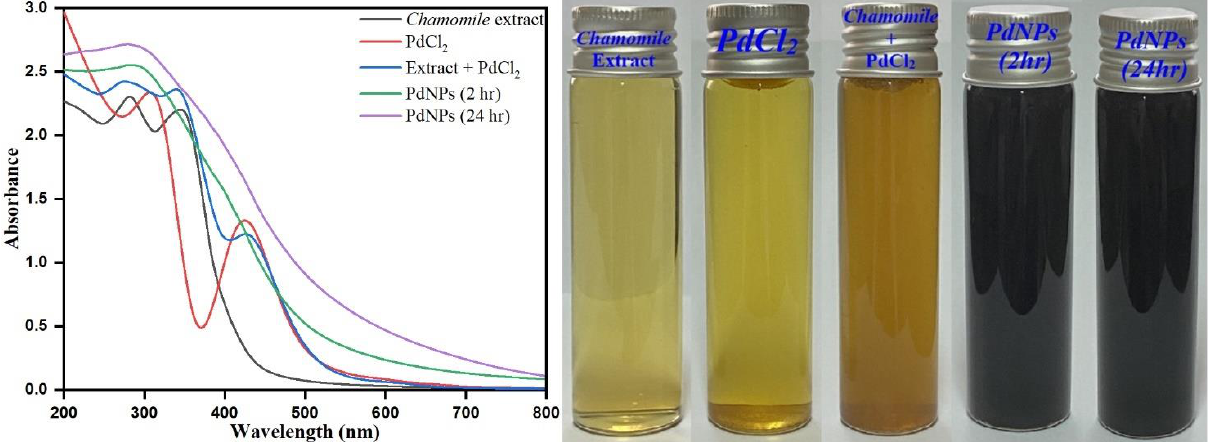
Figure 2. UV-visible spectrums of chamomile extract , PdCl 2 solution, Matricaria recutita flower extract + PdCl 2 reaction mixture, PdNPs at 2 h and PdNPs at 24 h and their respective optical images.